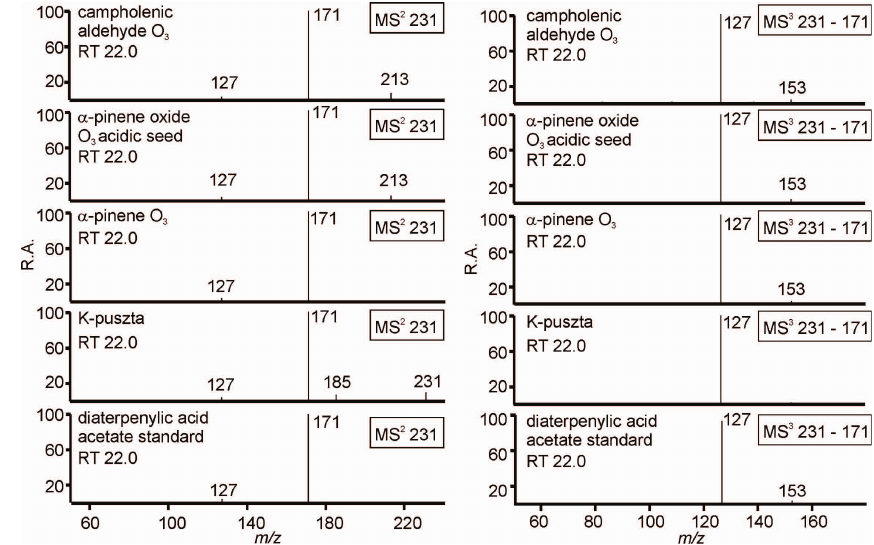
Fig. 3. MS 2 and MS 3 product ion spectra for the m / z 231 compound ( RT 22min) unambiguously identified as DTAA.